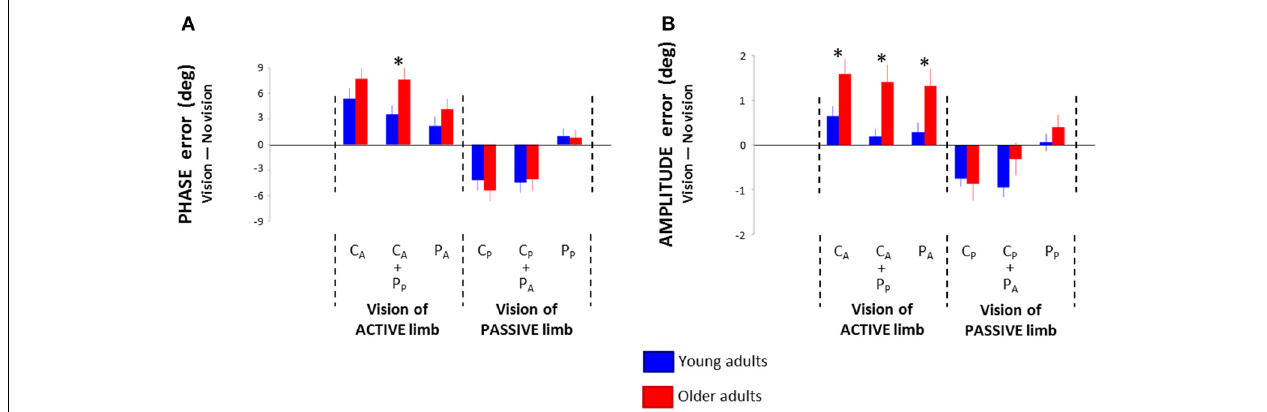
FIGURE 4 | Phase (A) and amplitude (B) root mean square difference between the no vision condition and the six visual conditions in young and older adults: central vision of the active wrist (C A ), central vision of the active wrist and peripheral vision of the passive wrist (C A + P P ),